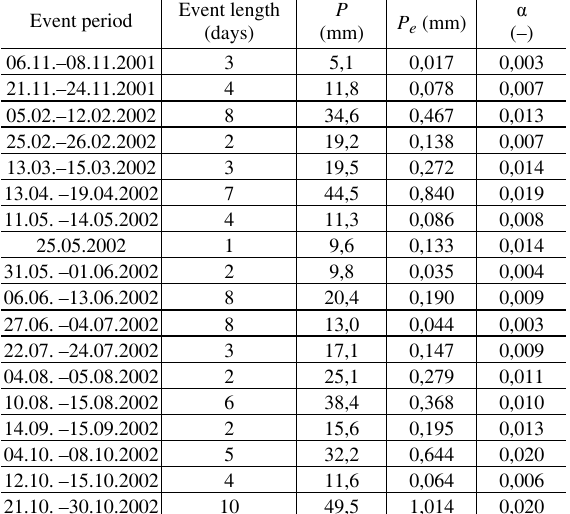
Table 1 . Empirical values of runoff coefficient ( α ), total ( P ) and effective rainfall ( P e ) for rainfall events in Tro- janka catchment for hydrologic year 2001/2002 Event